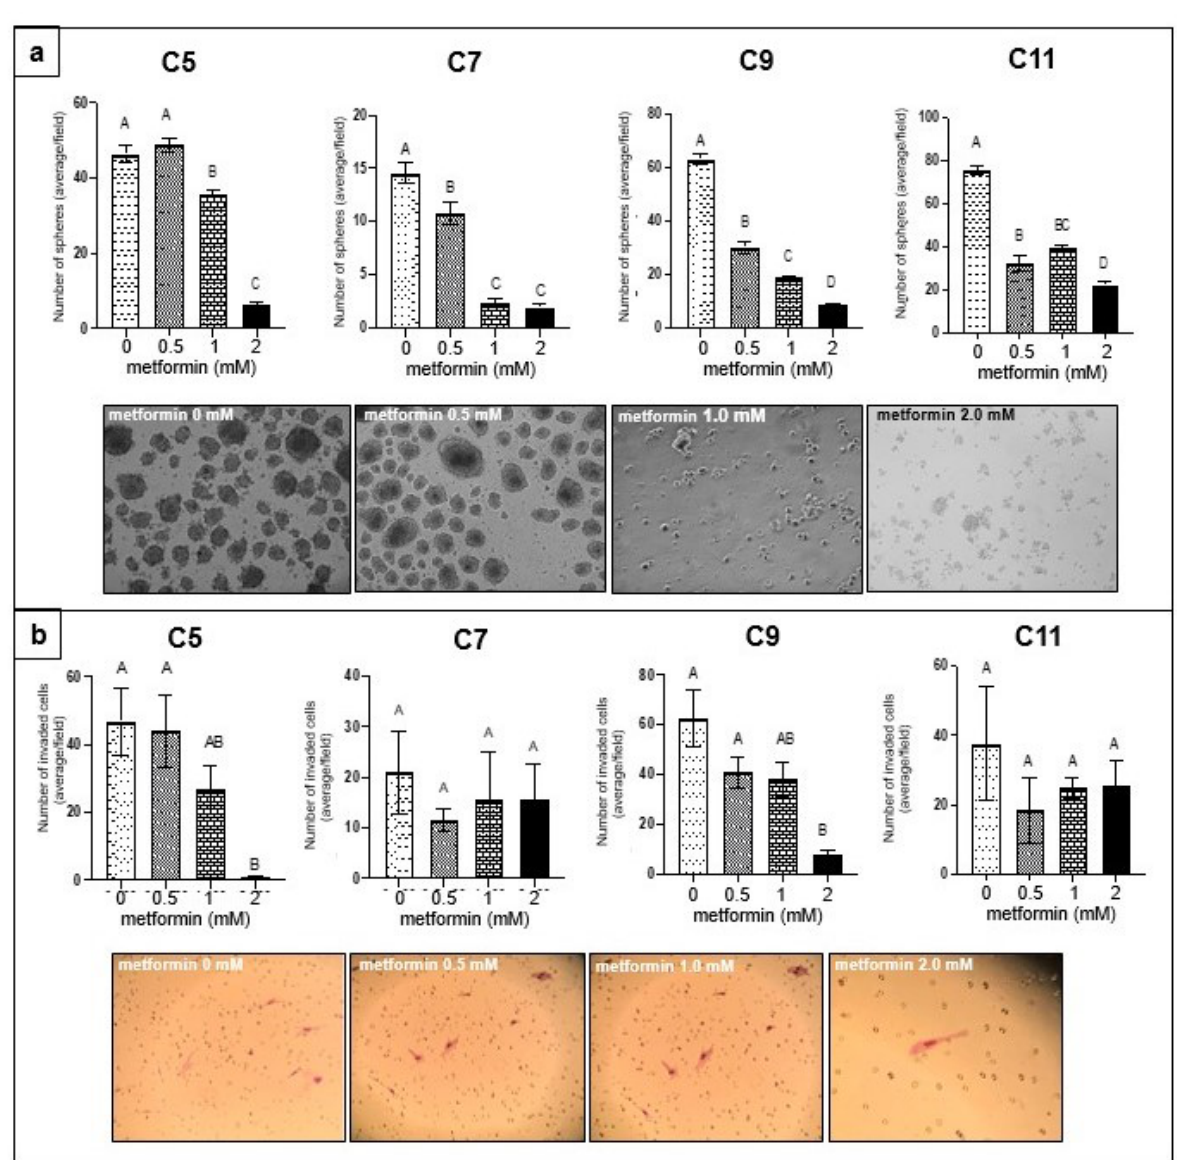
(Figure 1). Metformin treatment of C5 and C9 COVCAR cell lines resulted in significantly fewer number of cells that invaded Matrigel (Figure 1).